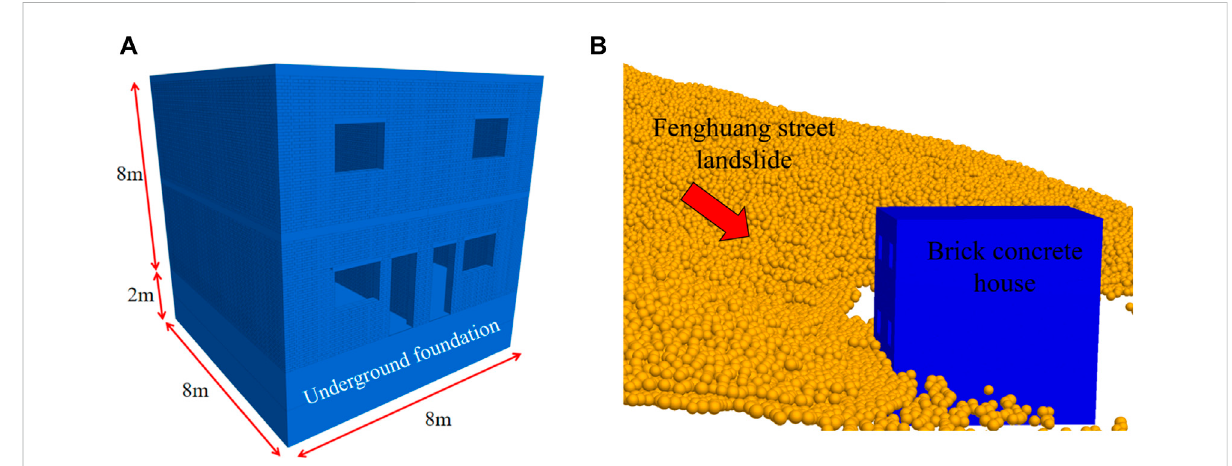
FIGURE 10 Landslide impact simulation: (A) a house model produced from discrete element method; (B) a rendering of the house affected by landslide.